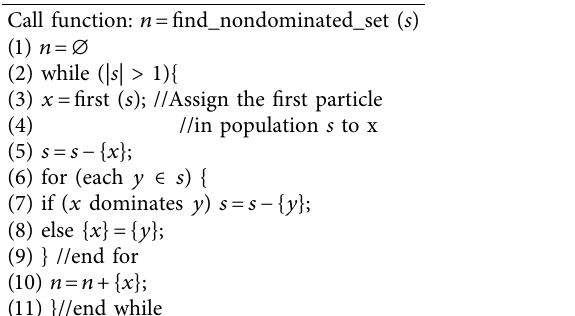
Table 1: Constructing nondominated set n by competition